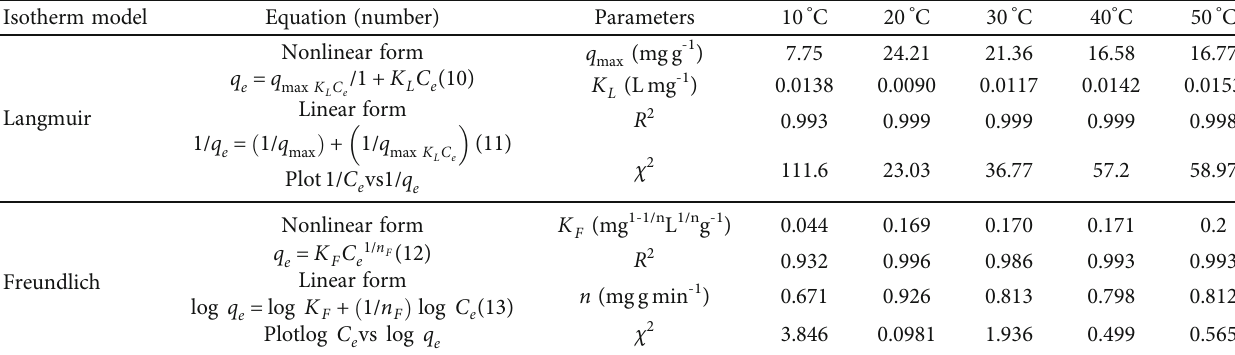
Table 5: Parameters of adsorption models applied in adsorption of the carmoisine on ND. Isotherm